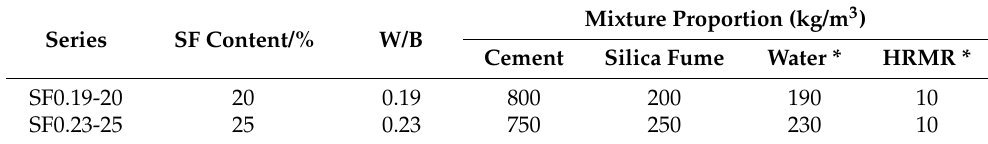
Table 2. Typical mixture proportions of CSHWM.